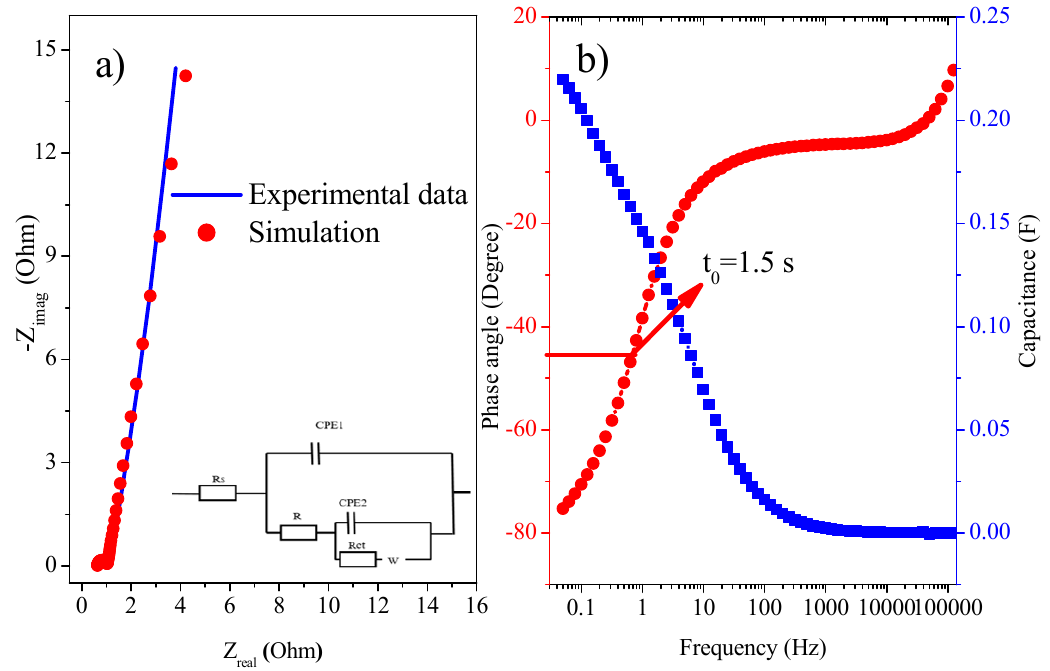
Figure 7. ( a ) Nyquist plot for asymmetric device (Inset: Equivalent circuit model). ( b ) Bode plot of asymmetric SC device.